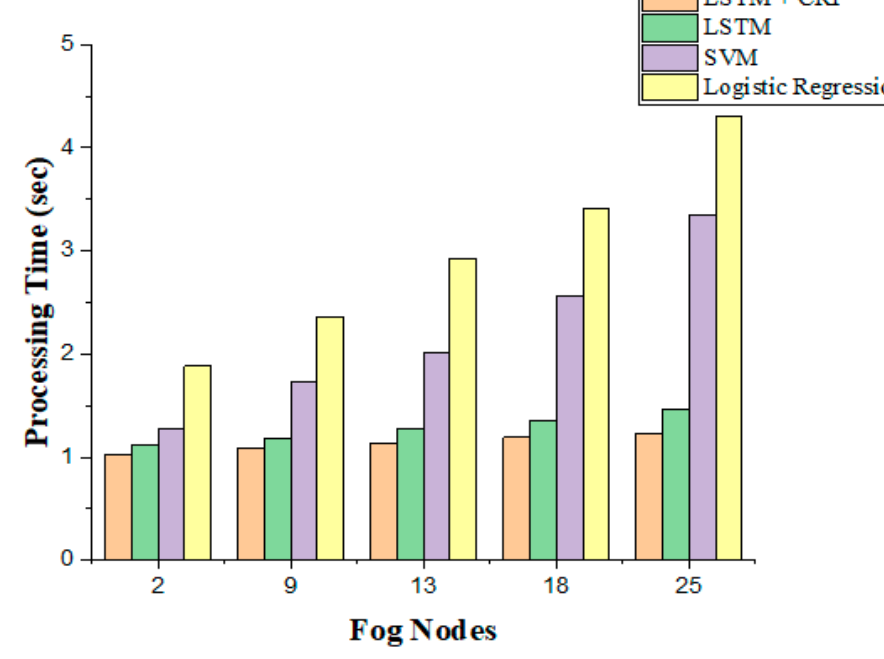
Figure 8. Minimum processing time.